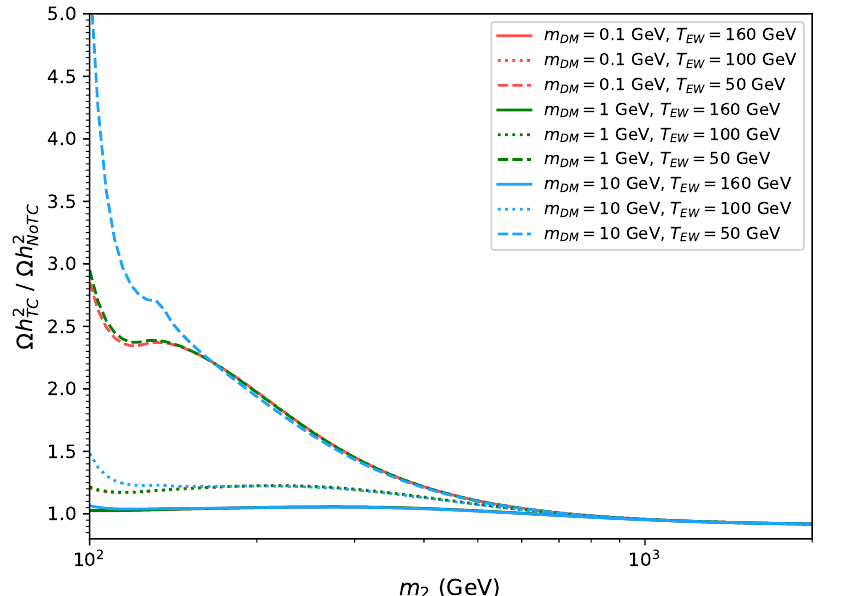
Figure 3 . Ratio (cid:10) h 2 as a function of m 2 for a DM mass m 1 = 0 : 1 GeV (red), m 1 = 1 GeV = (cid:10) h 2 TC NoTC (green) and m 1 = 10 GeV (light-blue), respectively for T EW = 160 GeV (solid line), T EW = 100 GeV (dotted line) and T EW = 50 GeV (dashed